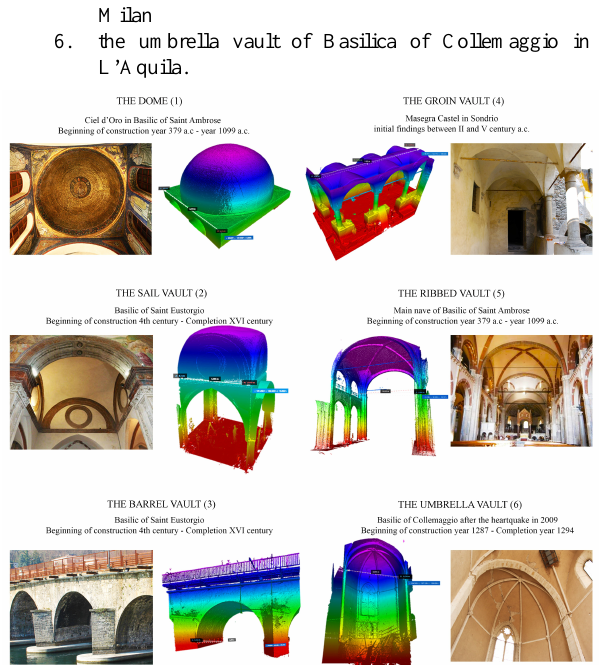
Figure 7. The wide variety of vaulted systems of the research case studies and the related point